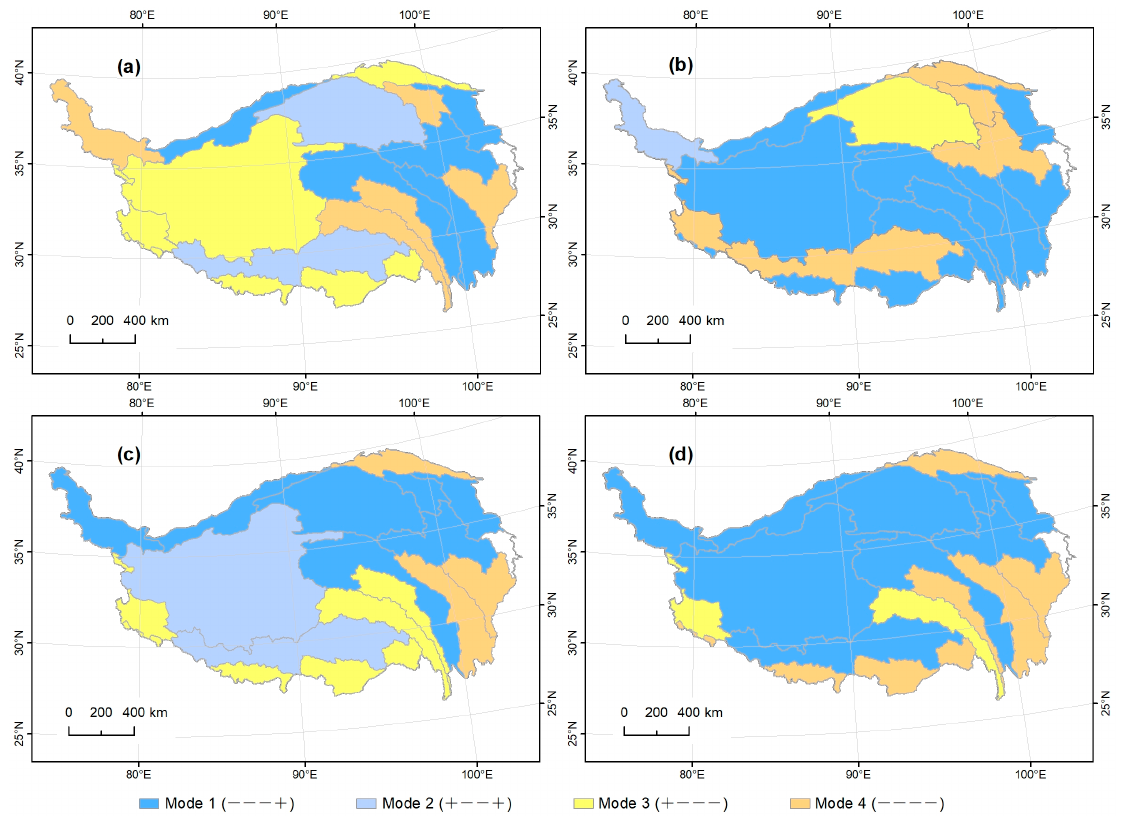
Figure 6. Spatial pattern of response modes of lakes during different periods. ( a – d ) represent the periods 1977–1990, 1990–2000, 2000–2014, and 1977–2014, respectively. “+” denotes increase and “ − ” denotes decline. These directions of change are provided for AI, glacier area, permafrost, and lake area. For example, Mode 1 is characterized by declines in both AI and glacier area, permafrost degradation, and an increase in lake area.